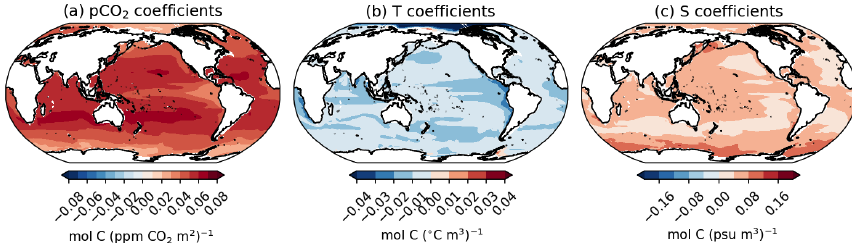
Figure 4. Ensemble coefficients for reconstructing upper-ocean (0–100m integrated) DIC with co-located observations. (a) Coefficients for annual-average atmospheric CO 2 concentrations (molC(ppmCO 2 m 2 ) − 1 ), (b) coefficients for upper-ocean integrated temperature (molC( ◦ Cm 3 ) − 1 ), and (c) coefficients for upper-ocean integrated salinity (molC(psum 3 ) − 1